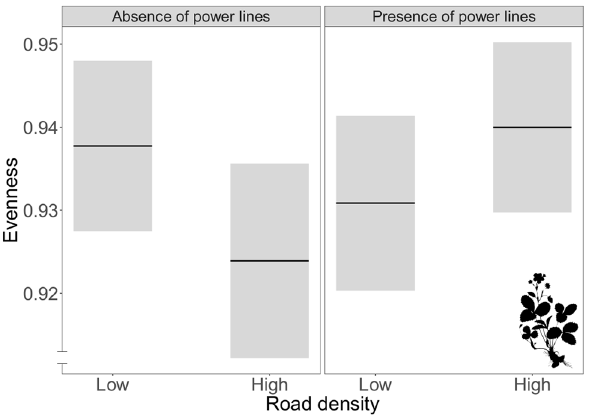
Figure 4. Interaction effect on the evenness (E Shannon ) of plant species in the landscape. In landscapes with no power line corridors, an increase in road verge density has a negative effect on the abundance distribution of plant species. In contrast, in landscapes with power line corridors, an increase in road verge density has a positive effect on the abundance distribution of plant species. Grey bars represent the 95% confidence intervals.